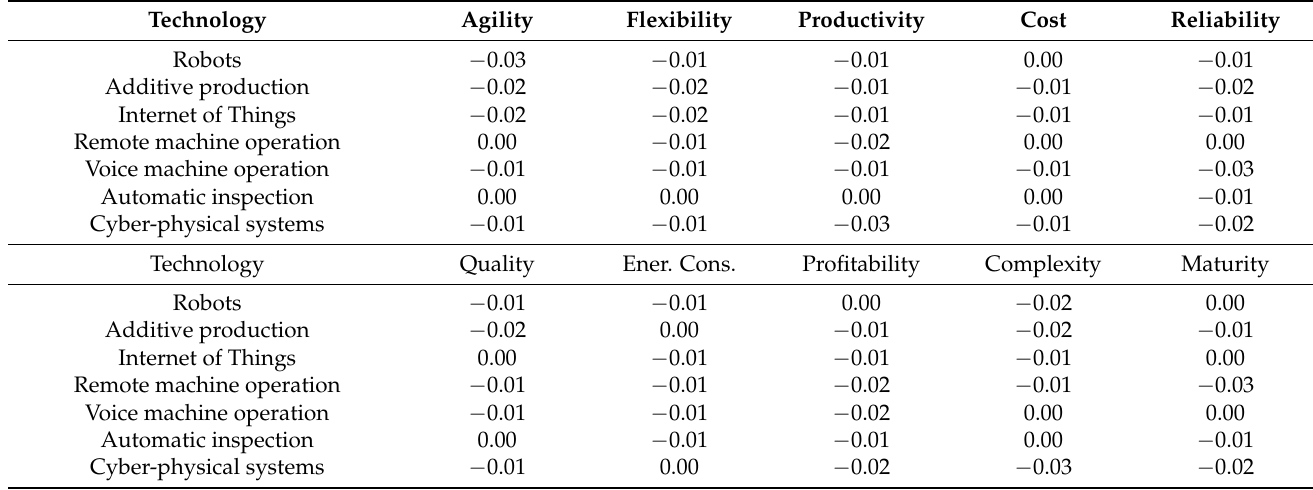
Table A10. The regret–rejoice utility matrix of weighted geometric